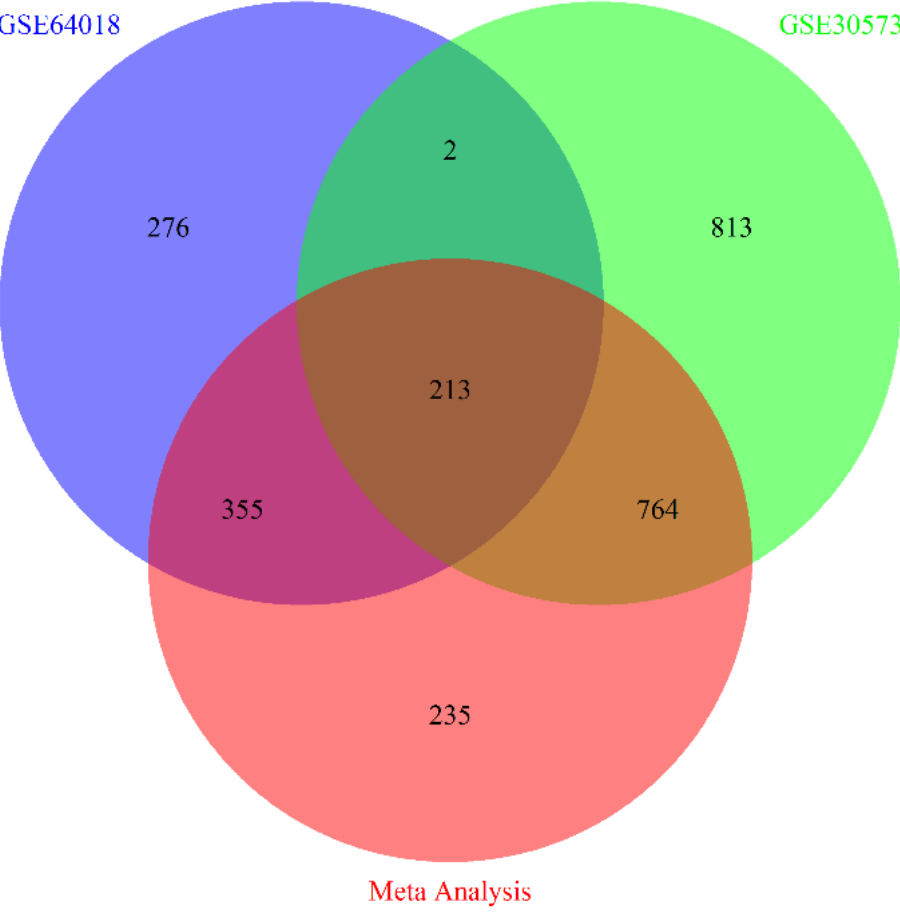
Figure 2. Venn diagram showing the number of differential expressed genes from individual studies and meta-analysis.